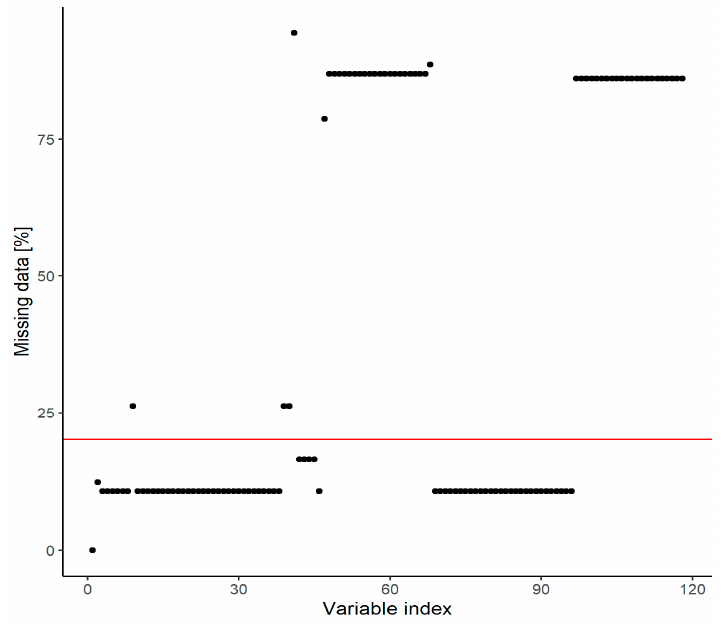
Figure 4. Percentage of missing values for each variable in the data set.